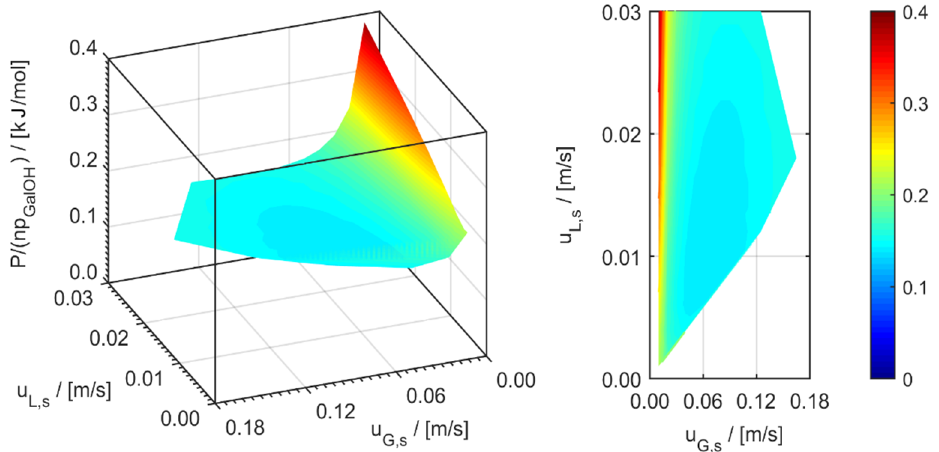
Figure 24. Specific energy consumption of trickle-bed reactors operating at different gas and liquid superficial velocities.